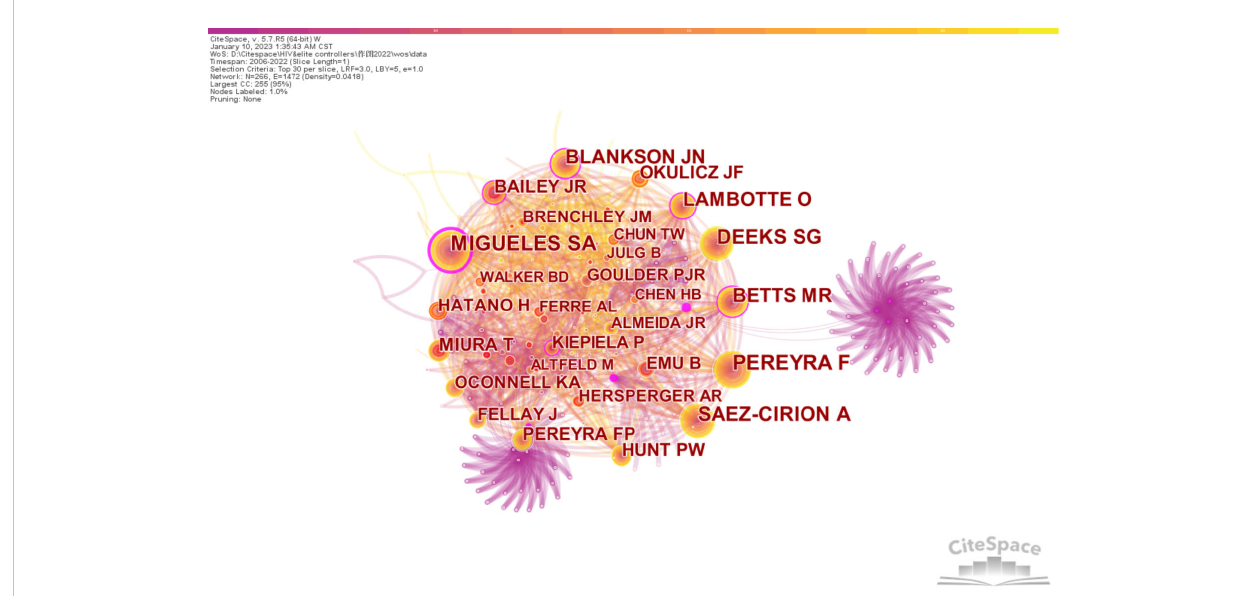
FIGURE 3 Visual analysis of 266 cocited authors in the fi eld of elite controller research via